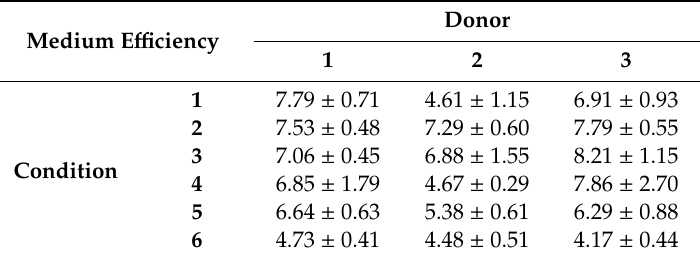
Table 3. E ffi ciency of medium used over the total cell culture period, calculated by dividing the total cell numbers by the total amount of medium used (10,000 cells mL − 1